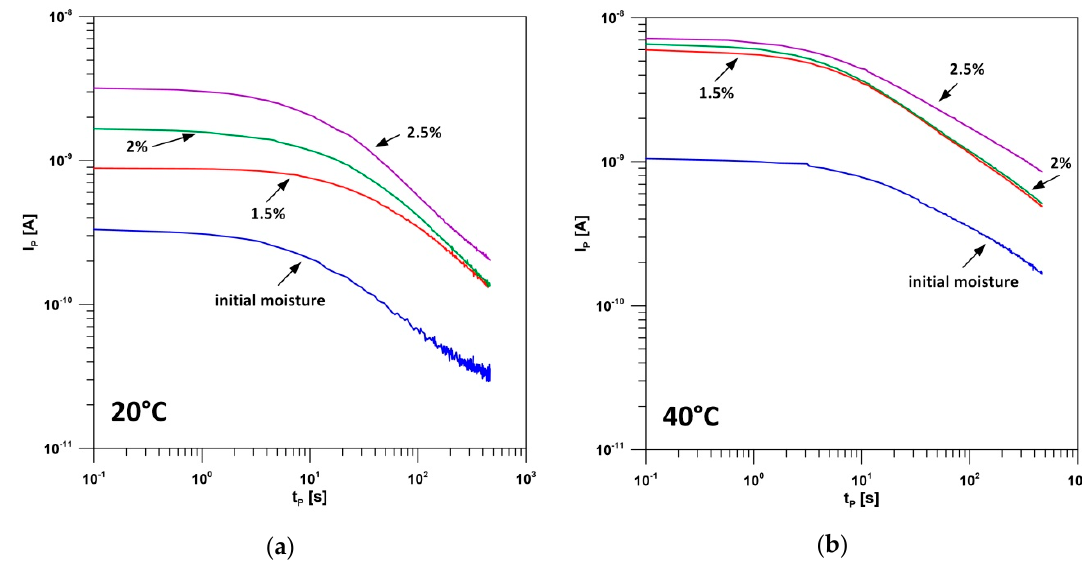
Figure 8. Characteristics of the polarization current of cellulose–aramid insulation sample with initial thermal ageing at 150 °C and with various moisture: ( a ) polarization currents in the measurement temperature 20 °C; ( b ) polarization currents in the measurement temperature 40 °C.